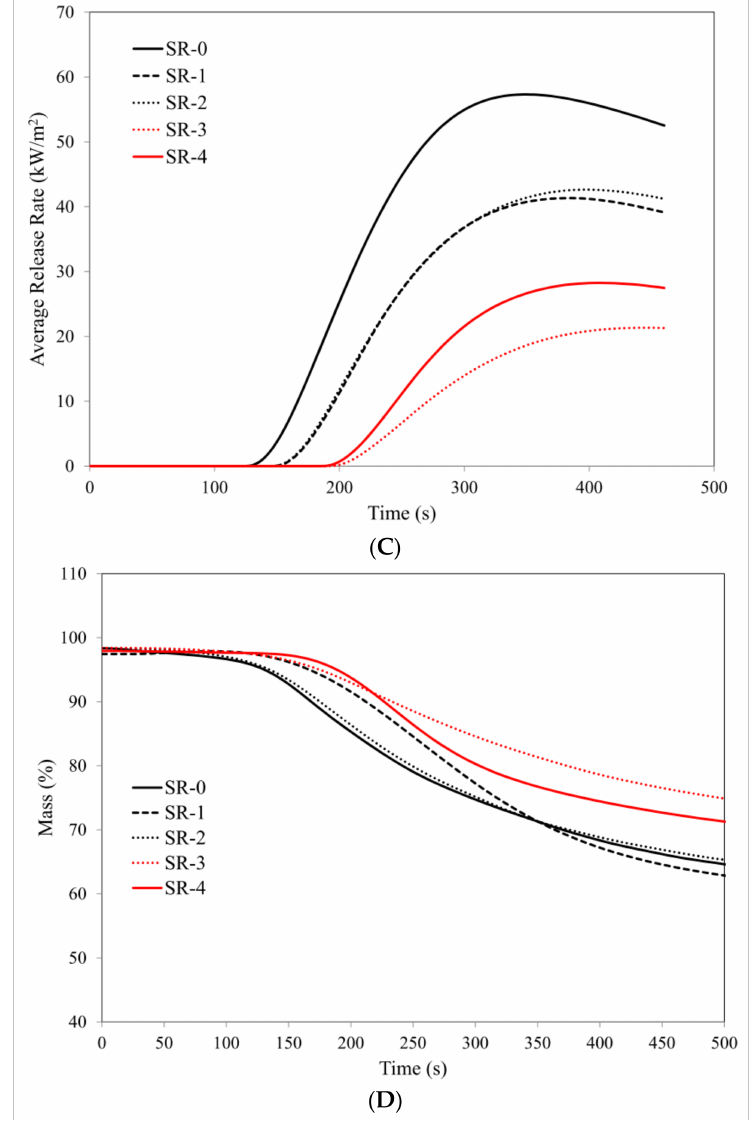
Figure 6. Cone calorimetry analysis: ( A ) max heat release rate, ( B ) total heat released, ( C ) average release rate (ARHE), ( D ) mass